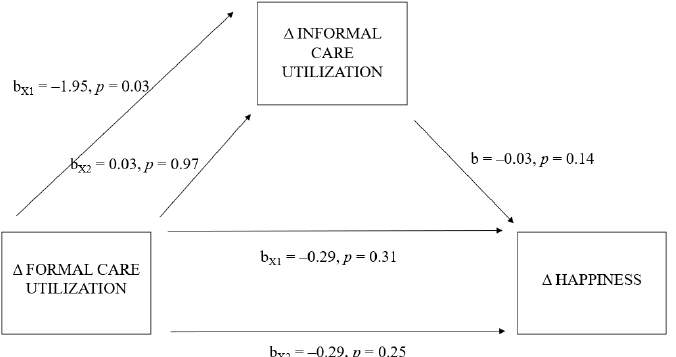
Figure 3. Model of shifts in formal care utilization as a predictor of change in happiness, mediated by shifts in informal care utilization. Note. Δ = difference between T0 and T1 .